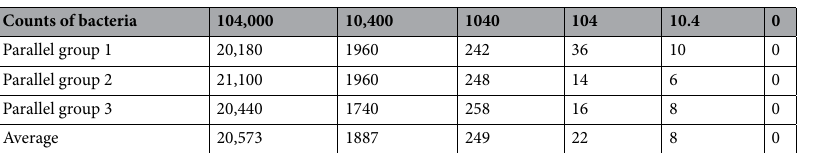
Table 7. Detecting E. coli ATCC25922 nucleic acid extracted from simulated bacteremia blood samples contaminated by Escherichia coli and Staphylococcus aureus.